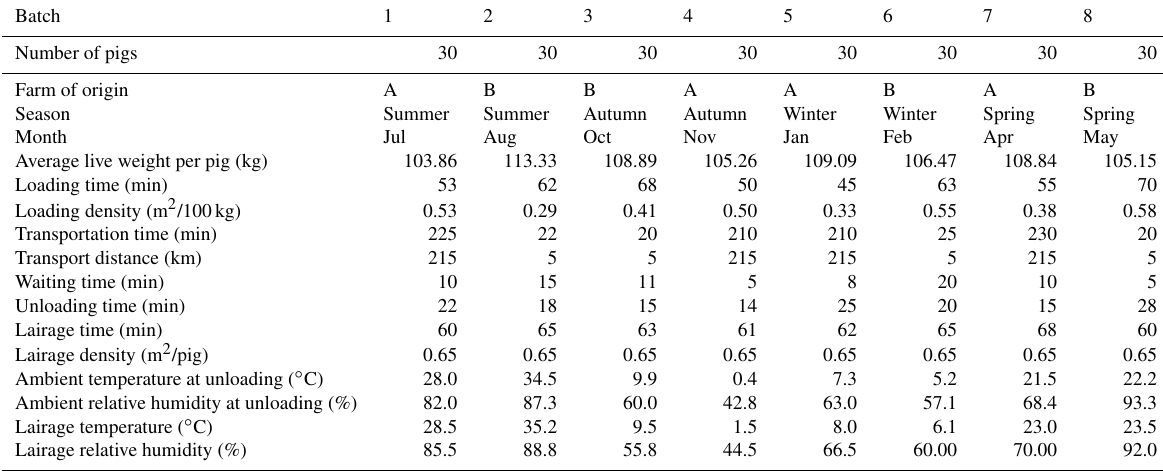
Table 1. The information about various pre-slaughter variables. Batch 1 Number of pigs